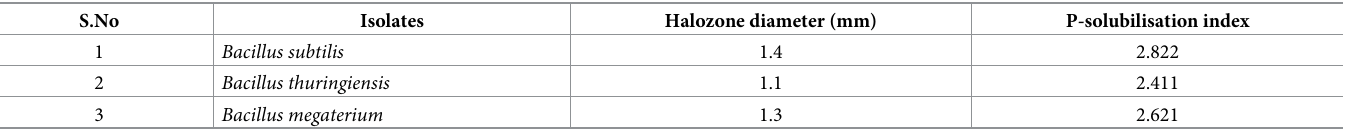
Table 2. P-solubilizing index of selected PGPR strains.